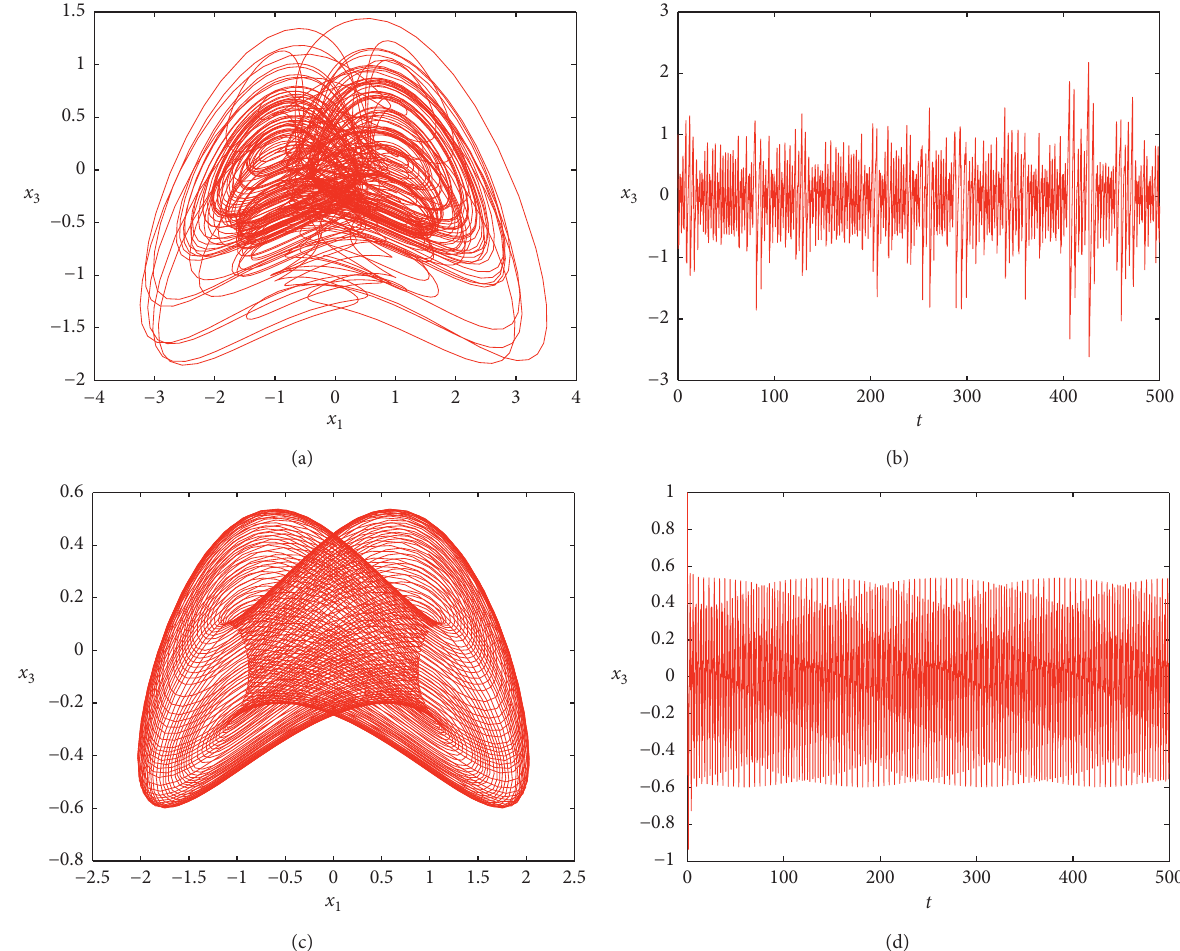
Figure 6: Chaotic and quasiperiodic motions of system (2) with a � 4 and b � 1: (a, b) c � 6; (c, d) c � 12.